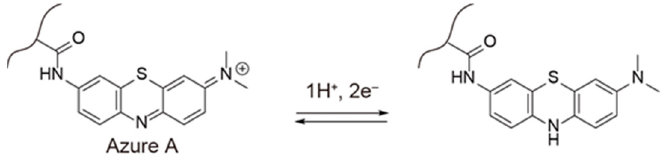
Figure 1. Structure of Azure A-modified poly(methacrylic acid) (AA-PMA) and its redox reaction.